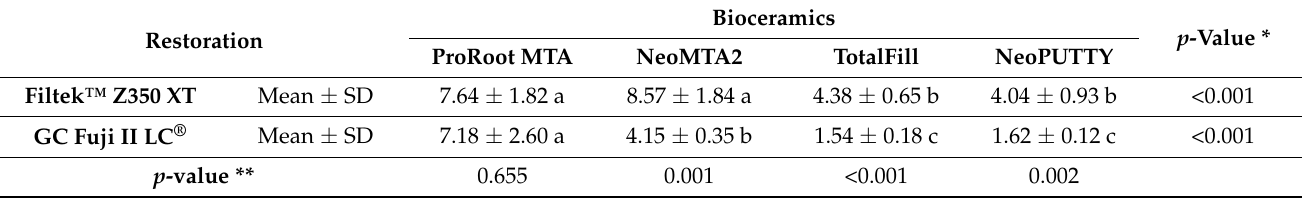
Table 3. Shear bond strength of different bioceramics with immediately placed Filtek™ Z350 XT